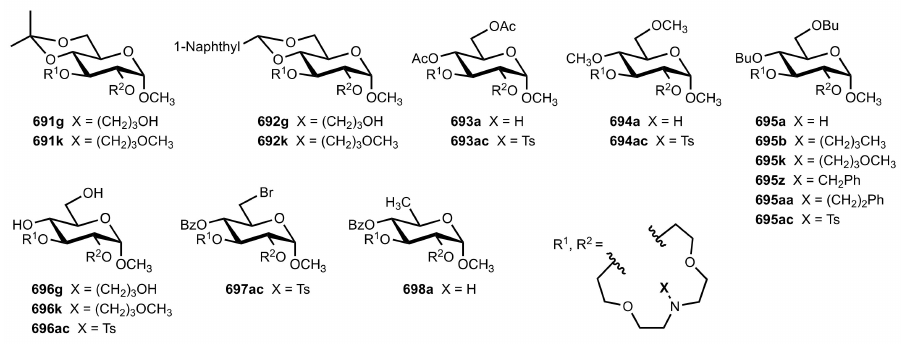
Figure 46. Newly synthesised aza-crown ethers bearing a methyl α - D -glucoside moiety.